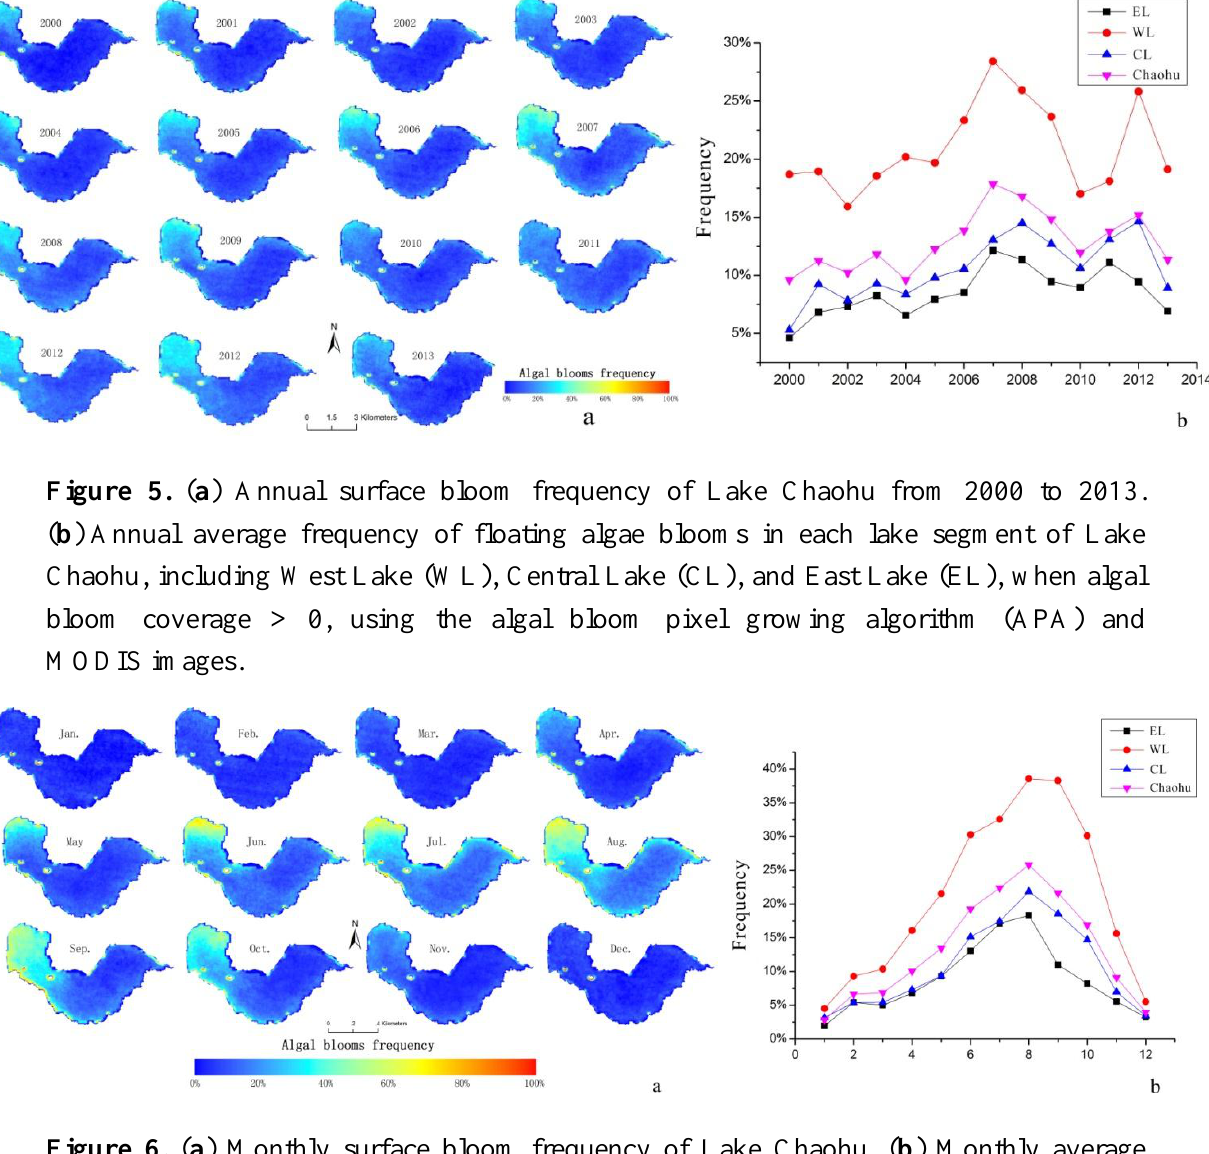
Figure 6. ( a ) Monthly surface bloom frequency of Lake Chaohu. ( b ) Monthly average frequency of floating algae blooms in each lake segment of Lake Chaohu, including West Lake (WL), Central Lake (CL), and East Lake (EL), when algal bloom coverage > 0, using the algal bloom pixel growing algorithm (APA) and MODIS